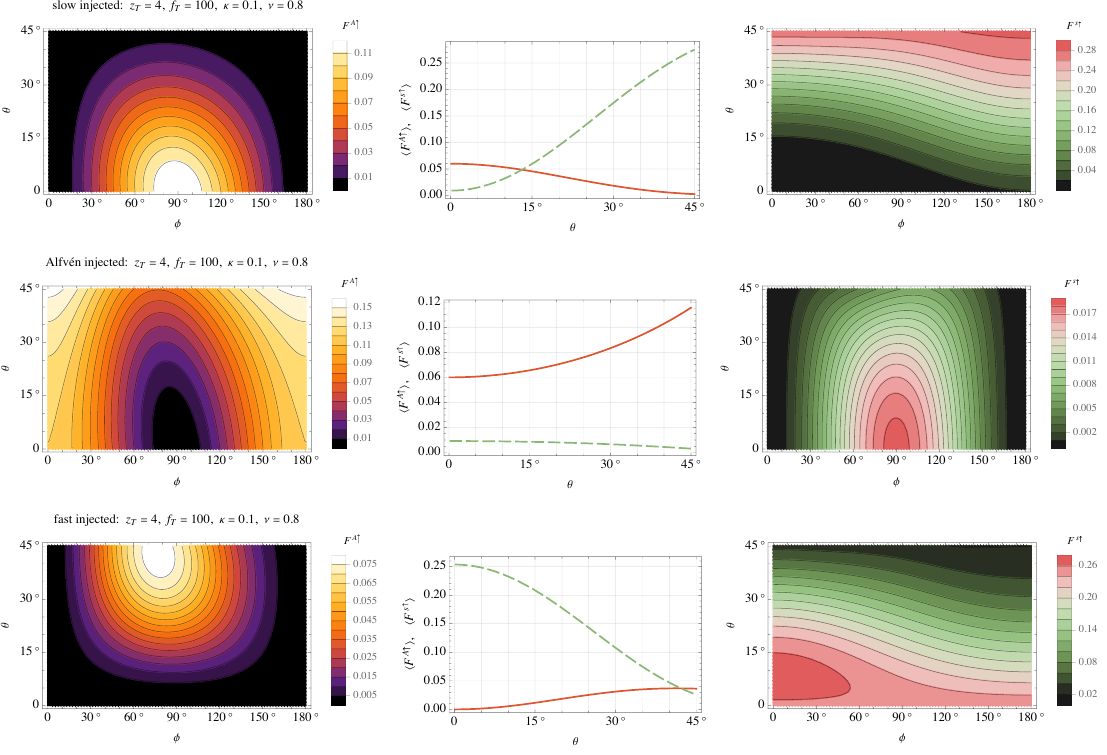
Figure 10. Same as Figure 9, but for ν = 0.8, which is slightly above both the cutoff and the frequency 0.74 beyond which the fast wave impacts the TR before reflecting.